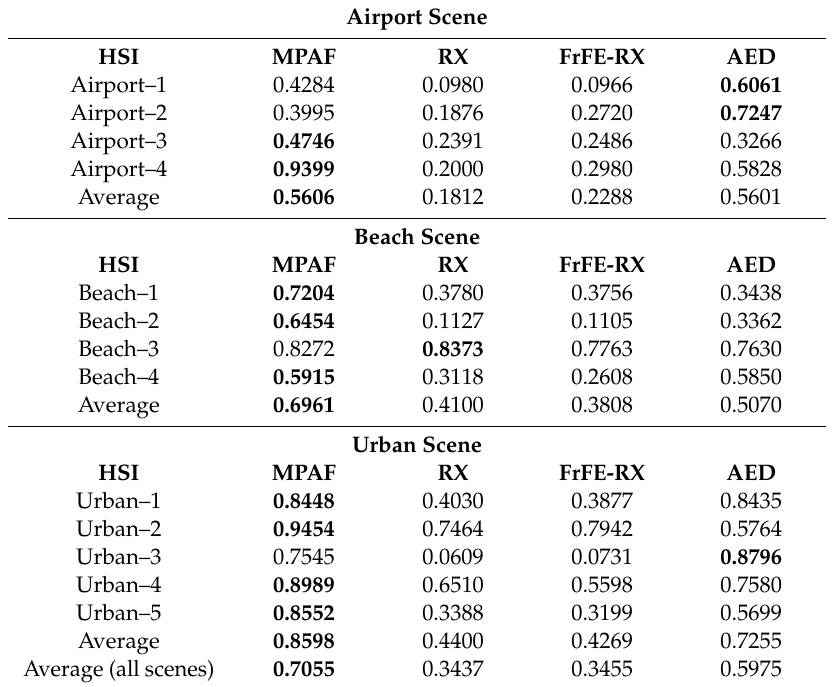
Table 3. AUC values of precision-recall curves for the compared methods on the ABU datasets.